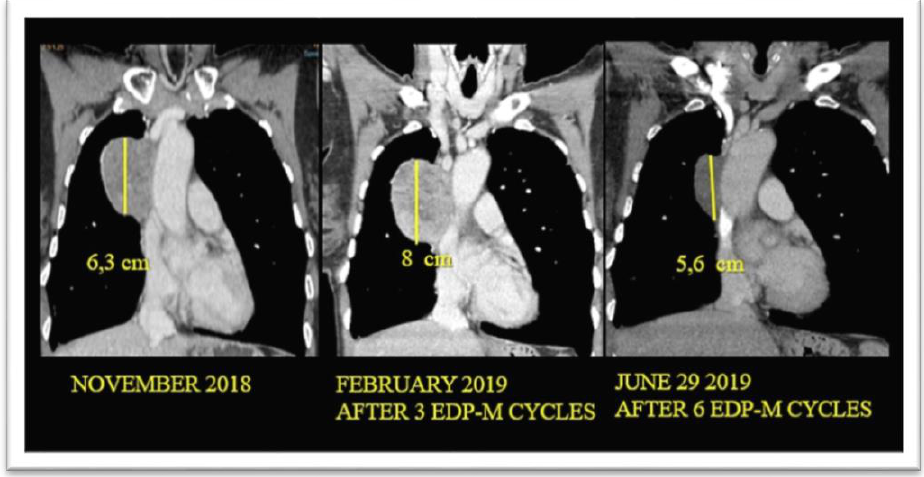
Figure 3. Thorax CT scan series of a patient attaining a pathological complete response after six